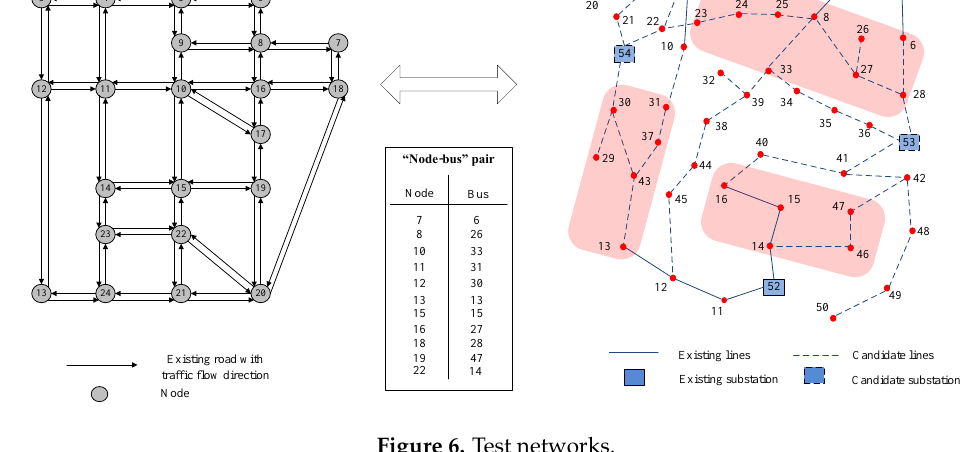
Figure 6. Test networks. Energies 2016 , 9 , 909